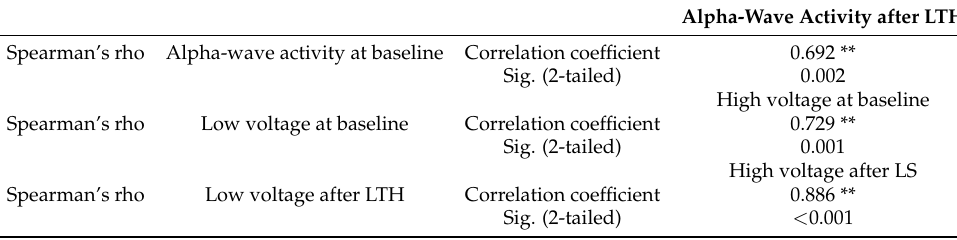
Table 13. Spearman correlations of SA group.